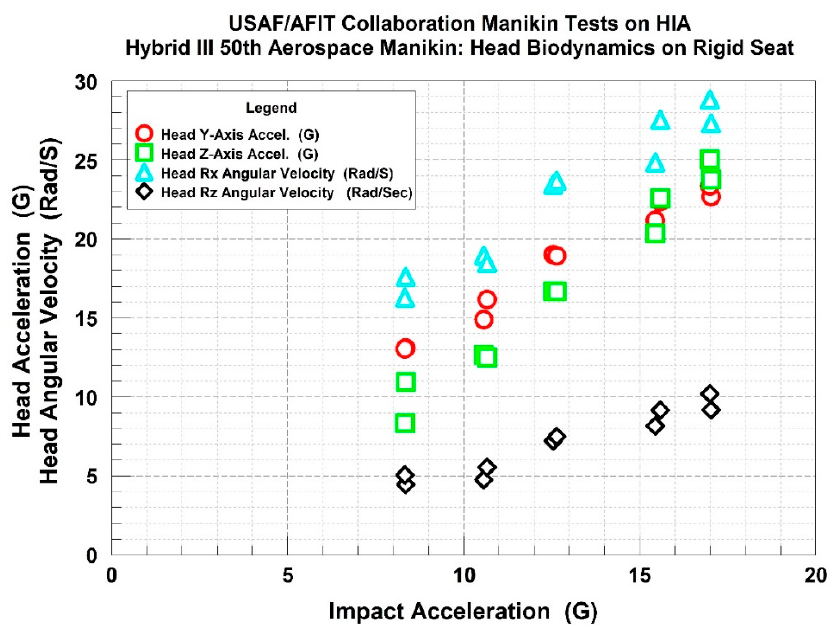
Figure 4. ATD head responses in the rigid seat. The plot shows the trend for the head z -axis (axial) and head y -axis (lateral) linear accelerations, and the head rotational velocities around the x -axis and the z -axis, to increase linearly as a function of the impact acceleration. The linear accelerations were very similar (circles and squares), but the rotational velocity around x -axis (triangles) was much greater than the velocity around the z -axis (diamonds).